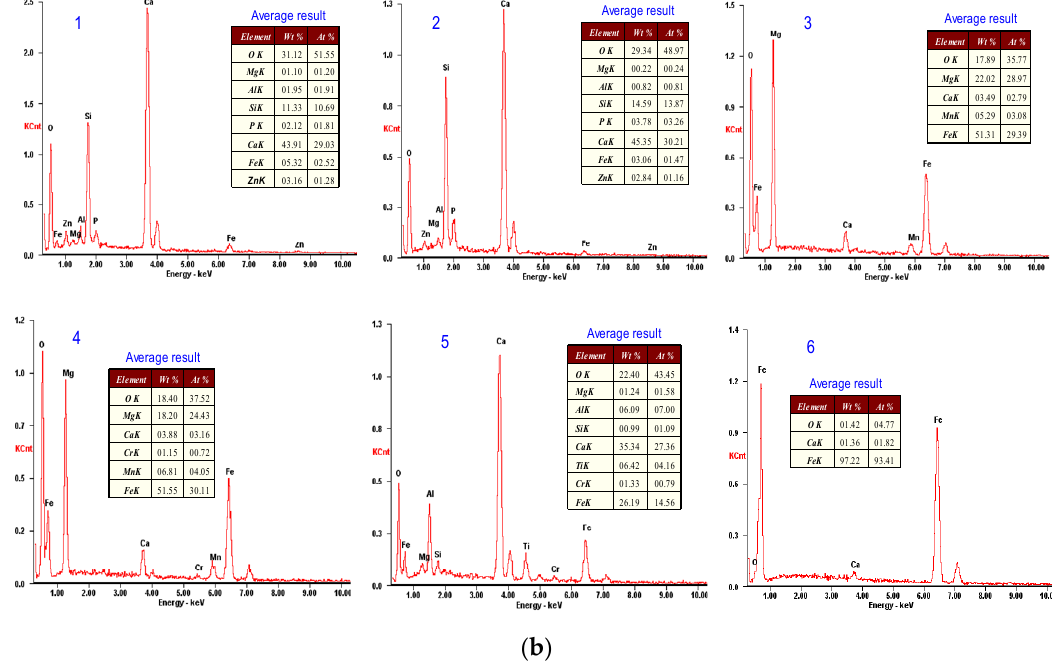
Figure 2. Morphologies and identification of mineral phases in converter steel slag. ( a ): Back-scattered electron (BSE) images of various mineral phases; ( b ) Energy dispersive X-ray spectroscopy (EDX) analysis results of various mineral phases.